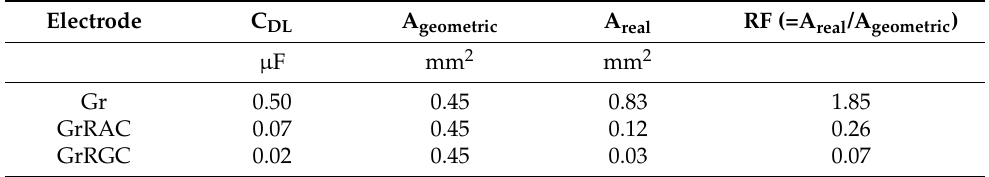
Table 1. Differential capacitance (C DL ), geometric area (A geometric ), electroactive surface area (A real ) and roughness factor (RF) for the cork-graphite